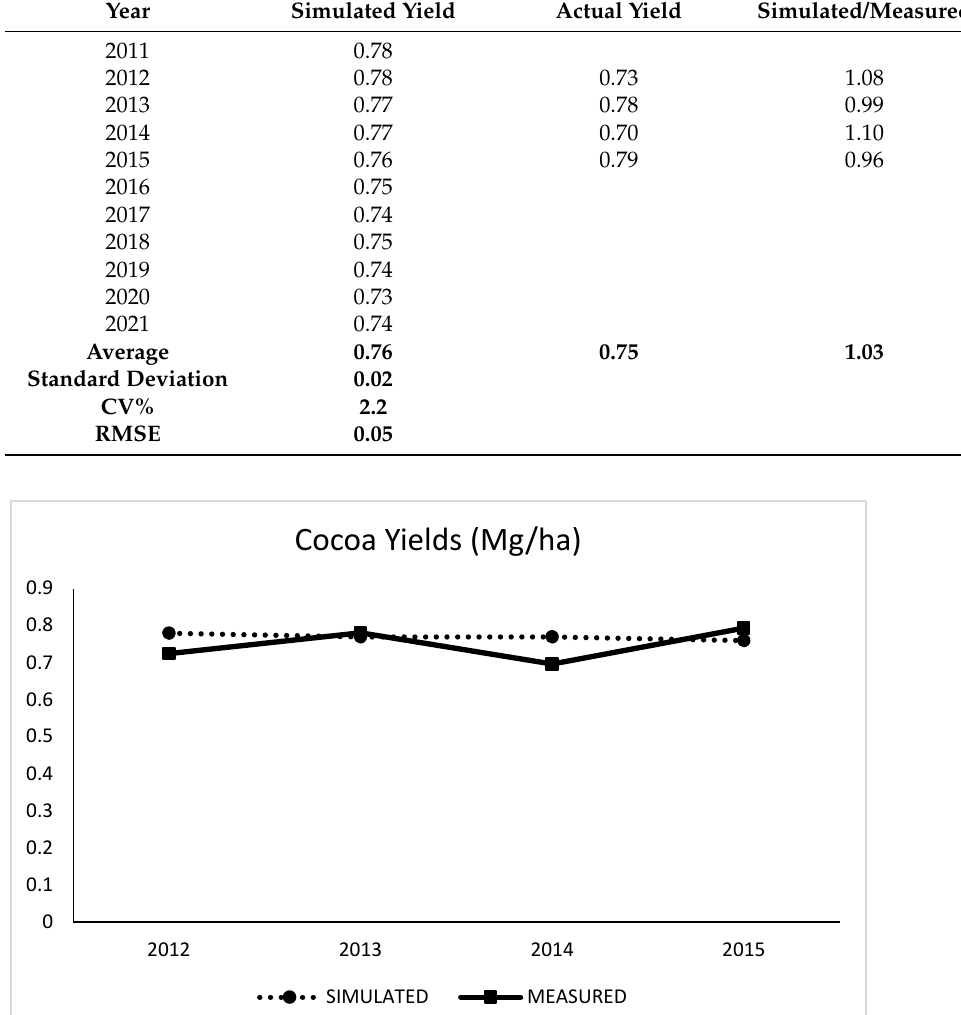
Figure 2. Cocoa yields (in Ghana) measured and simulated with the ALMANAC model. Table 9. Sensitivity analysis of yield responses to changes in rainfall.